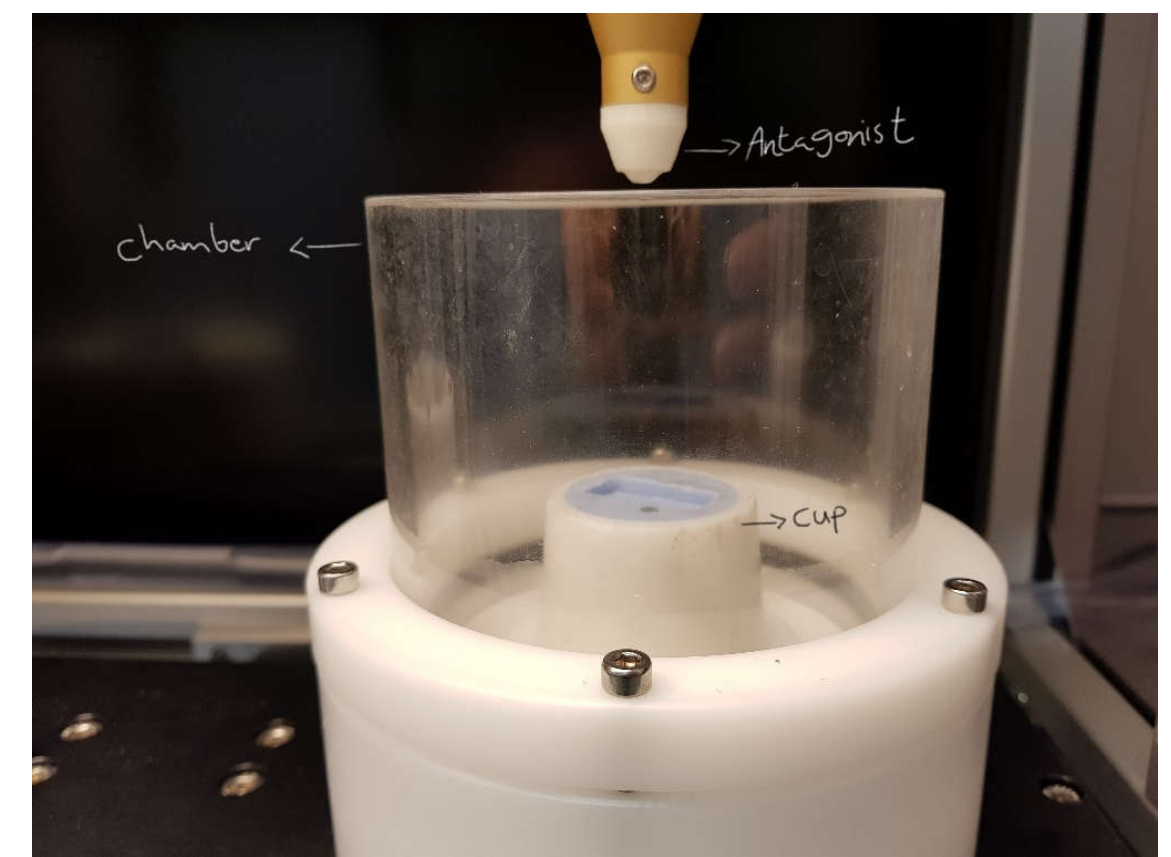
Figure 2. Chewing simulator